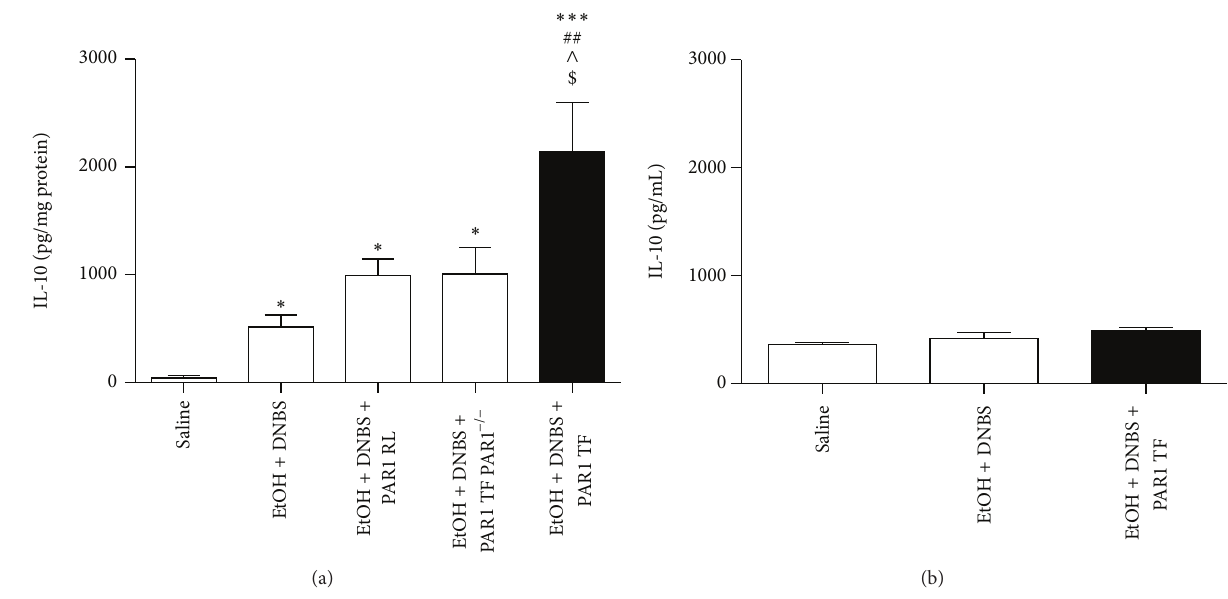
Figure 7: Instillation of the PAR1 activating peptide TFLLR-NH 2 significantly increases IL-10 concentration in the inflamed prostates of wild- type but not PAR1 −/− mice and does not change IL-10 levels in serum. Prostates were treated with sterile saline in wild-type mice (saline), ethanol + dinitrobenzene sulfonic acid in wild-type mice (EtOH + DNBS), ethanol + dinitrobenzene sulfonic acid + PAR1 reverse peptide RLLFT-NH 2 in wild-type mice (EtOH + DNBS + PAR1 RL), ethanol + dinitrobenzene sulfonic acid + PAR1 activating peptide TFLLR-NH 2 in PAR1 knockout mice (EtOH + DNBS + PAR1 TF PAR1 −/− ), or ethanol + dinitrobenzene sulfonic acid + PAR1 activating peptide TFLLR-NH 2 in wild-type mice (EtOH + DNBS + PAR1 TF) for 2 days. The inflammatory response was measured by monitoring (a) prostatic interleukin- 10 (IL-10), and (b) serum IL-10. Data are mean ± SEM of 𝑛 = 4 –7 per group. ∗ 𝑃 < 0.05 , ∗∗∗ 𝑃 < 0.001 for treatment groups versus saline; ## 𝑃 < 0.01 for EtOH + DNBS + PAR1 TF versus EtOH + DNBS; ∧ 𝑃 < 0.05 for EtOH + DNBS + PAR1 TF versus EtOH + DNBS + PAR1 RL; $ 𝑃 <